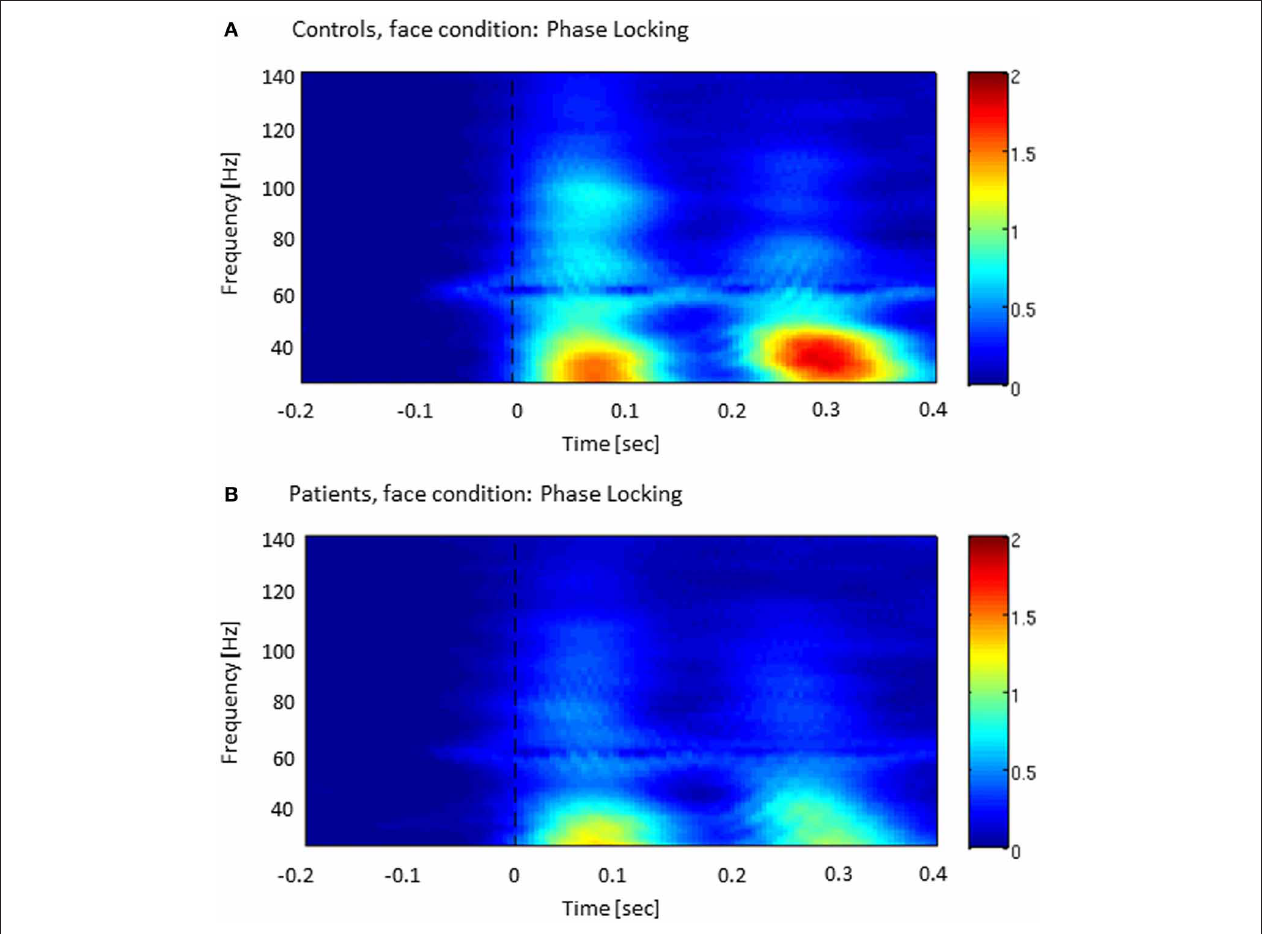
FIGURE 2 | Inter-trial phase-coherence (ITPC) across all sensor-groups in both controls (A) and patients with schizophrenia (B). The colored scale (0–2) indicates change in ITPC relative to baseline.